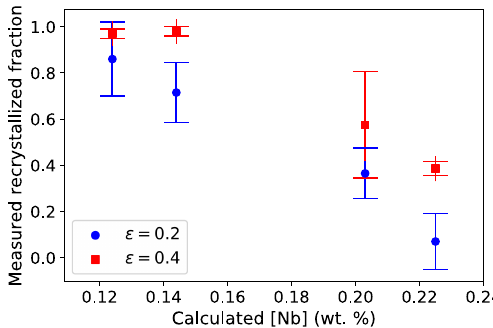
Figure 13. Recrystallized fraction of austenite in 316Nb steel after hot torsion tests determined on EBSD (lower value: GOS < 1° and upper value: GOS < 2°)) at strains of ε = 0.2 and ε = 0.4 as a function of mean Nb content in austenite after different heat treatments prior to deformation, as predicted using reduced thermokinetic model ( r Nb ( C,N ) = 1 µm, complete 316Nb composition (nine-element simulation) and the TCFE9